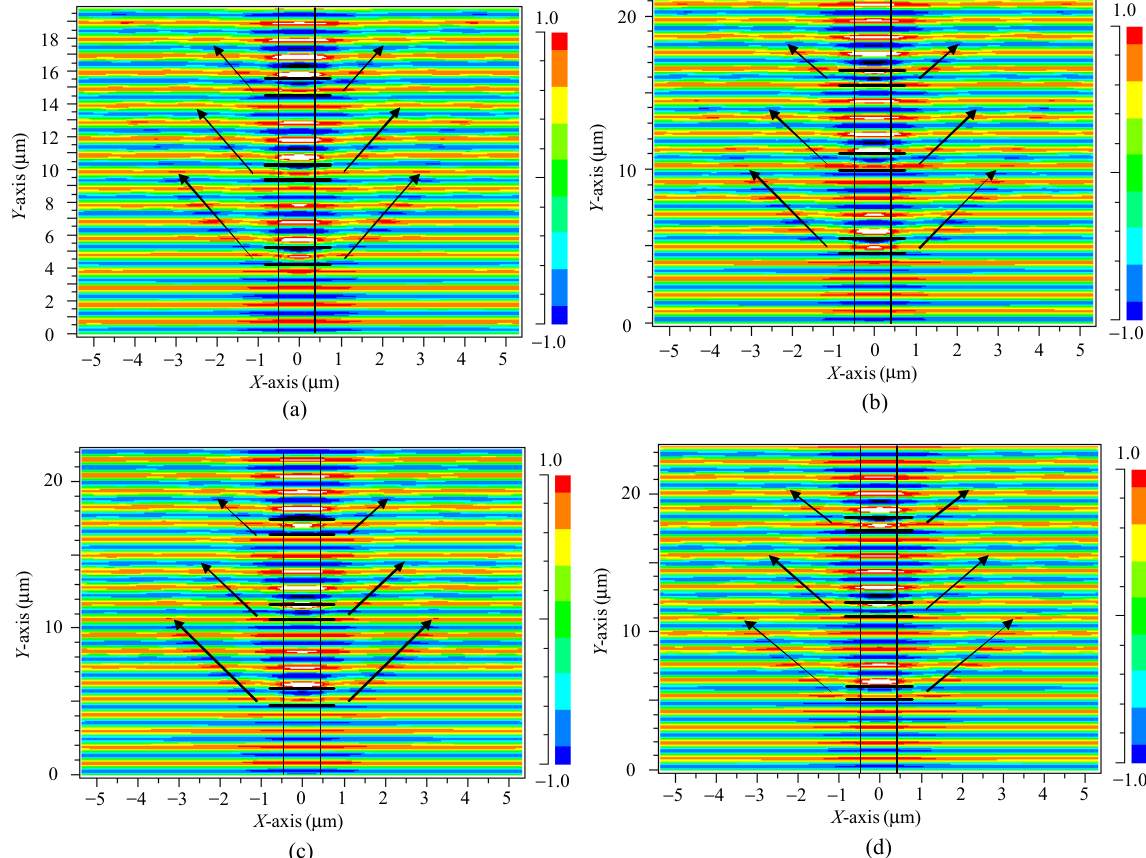
Fig. 7 Electric field distribution through the grating structure with the period of (a) 5.2 µm, (b) 5.5 µm, (c) 5.8 µm, and (d) 6.1 µm. everywhere on the pitch and its amplitude is a function of